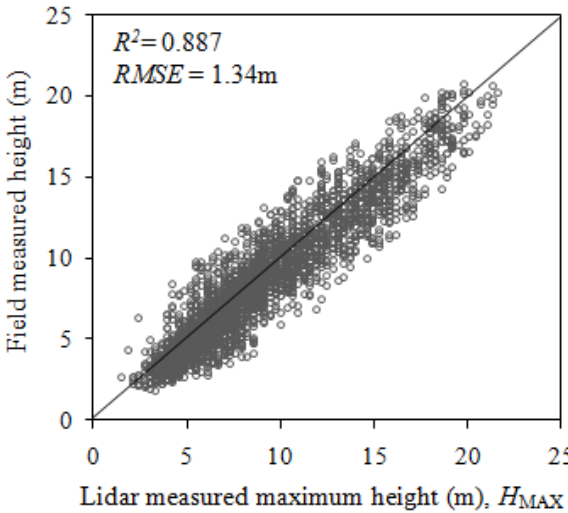
Figure 3. Relationship between field-measured height and lidar-measured maximum